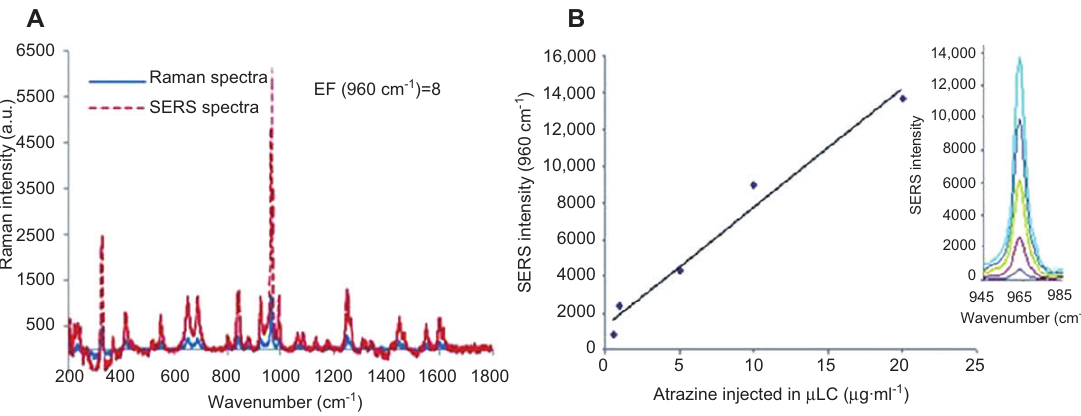
Figure 4 (A) Raman and SERS spectra of atrazine for 10 μ g ml -1 injected in μ LC column. (B) Calibration curve using SERS spectra collected from spots at different amounts injected in the μ LC column (between 0.5 and 20 ng) for atrazine, plus the corresponding Raman peak used as the analytical signal. Reproduced with permission from: Carrillo-Carrion et al. (2012) . Copyright 2012,